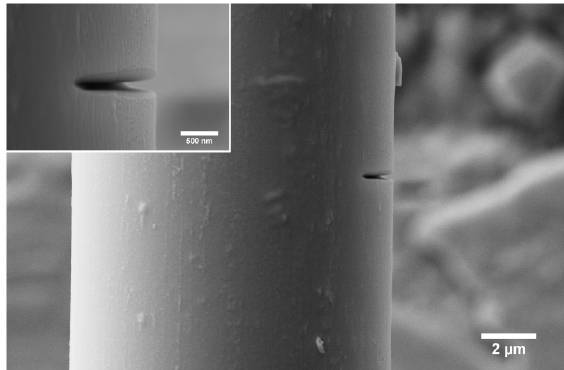
Figure 7. SEM micrographs of artificially notched basalt fibre.